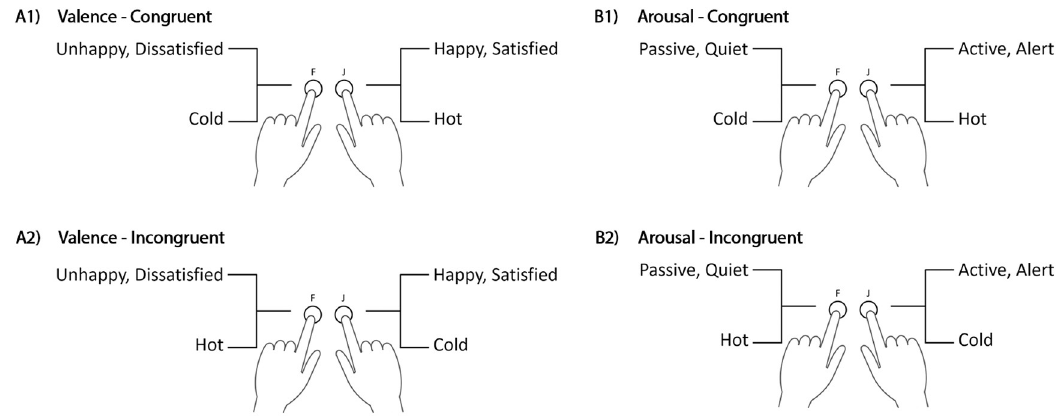
Fig 7. Stimulus-response key assignment in Experiment 2. The left-hand side (A1, A2) corresponds to assignments in the valence dimension, and the right-hand side (B1, B2) corresponds to the arousal dimension. Congruent assignments are presented in the upper panels and incongruent assignments are presented in the lower